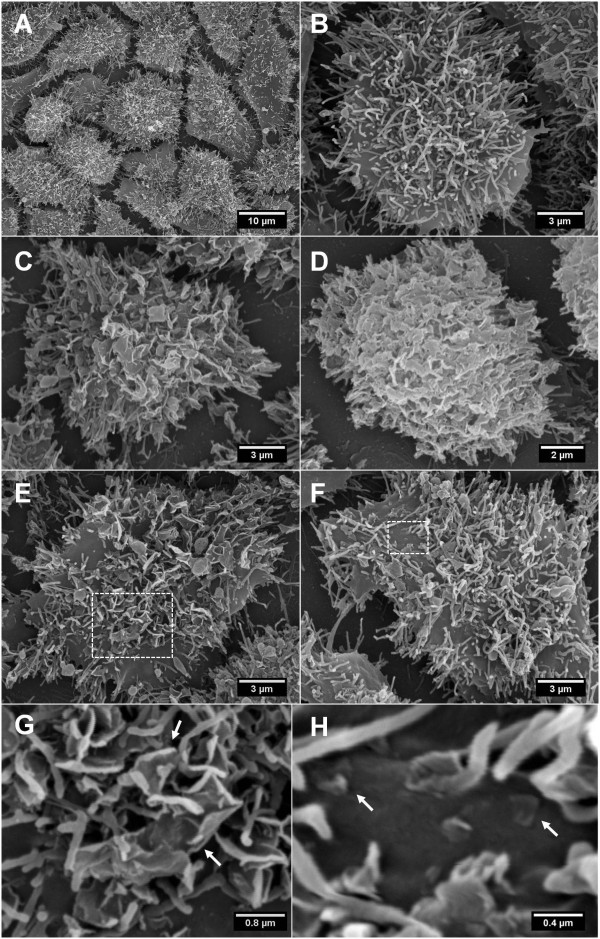
SEM micrographs of Hep G2 cells after exposure to GO and CXYG for 24 h. Images A and B show SEM micrographs of non-treated cells at 1500X and 5000X magnification. The scale bars in these images correspond to 10 and 3 μm, respectively. Control-cells demonstrated healthy cell morphology with numerous microvilli protruding from the cell surface. Images C and D show SEM micrographs of cells treated with 16 μg/ml GO and 32 μg/ml CXYG, respectively. GO and CXYG platelets deposited and formed a layer completely covering the cell surface. The scale bar displayed in C and D corresponds to 3 and 2 μm, respectively. Images E and F show SEM micrographs of cells treated with of 8 μg/ml GO and CXYG, respectively. At this concentration cells were only partly covered with nanomaterial. The scale bars in E and F correspond to 3 μm. The boxed-in areas (white, dotted line) are shown at higher magnification in images G and F, respectively. Image E shows the interaction of micro-sized GO platelets (white arrows) with microvilli. Image F shows the interaction of CXYG nanoplatelets with lateral dimensions between approximately 200 and 400 nm with the plasma membrane (white arrows). The scale bar in G and H is 0.8 and 0.4 μm, respectively.